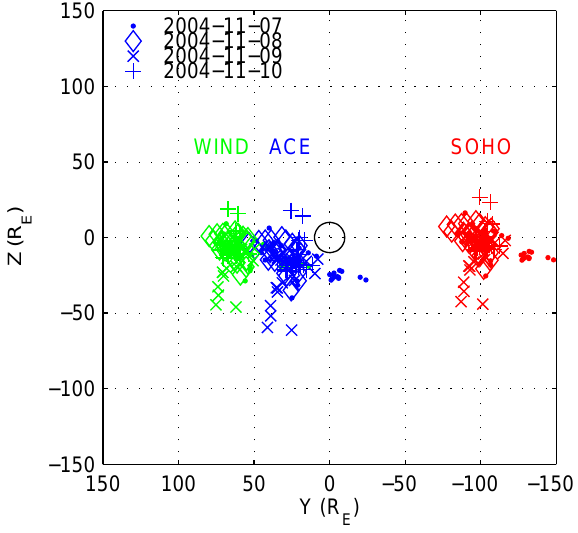
Fig. 5. The three panels show, from top to bottom: solar wind B z (blue) and − B z (red), predicted RMS 1X using B z (blue) and − B z (red), and predicted RMS 1Y using B z (blue) and − B z (red). not represent accurately the solar wind close to the